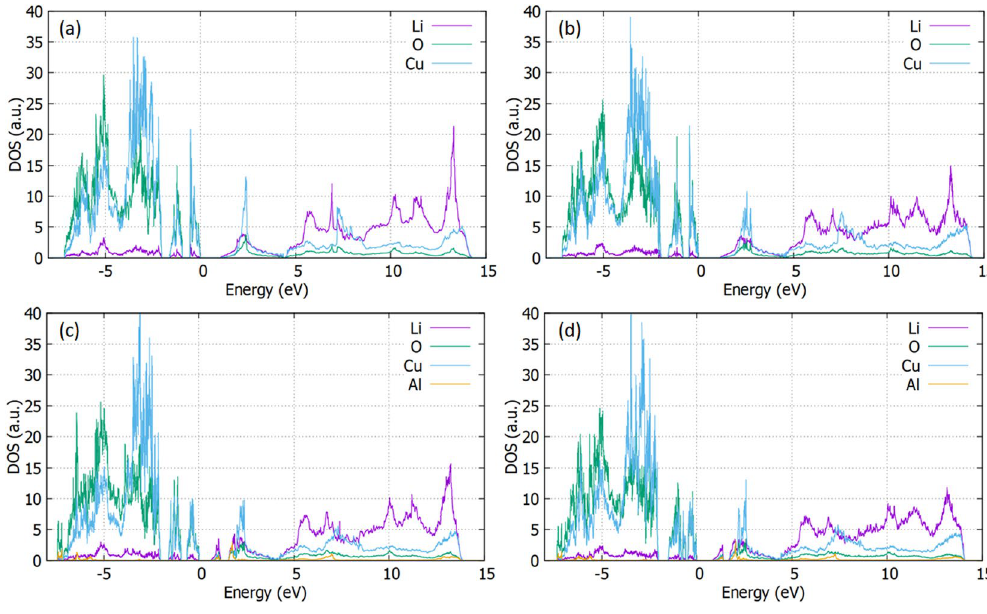
Figure 5. The densities of states for Li 2 CuO 2 : ( a ) perfect cell ( b ) ′ V